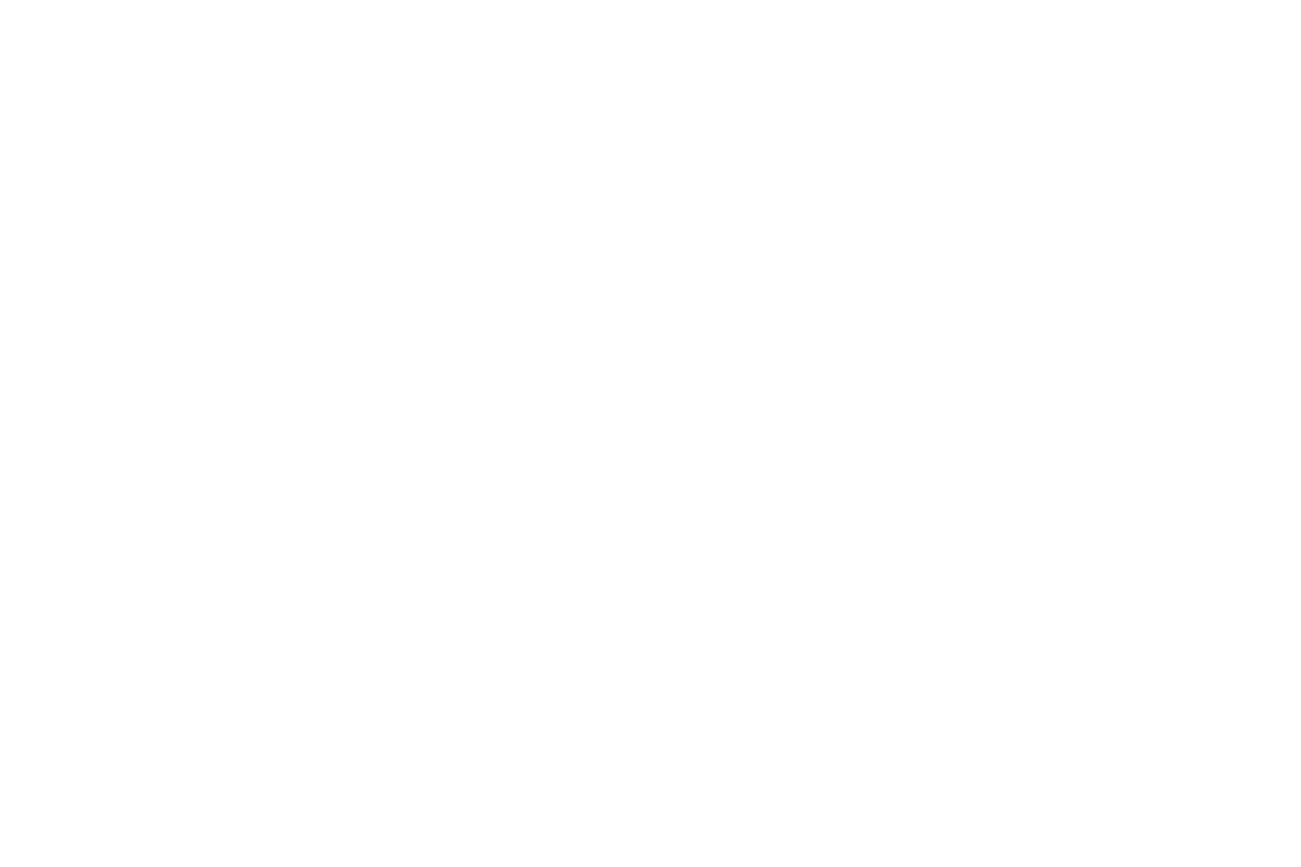
Frontiers in Plant Science | Plant Proteomics July 2012 | Volume 3 | Article 153 |